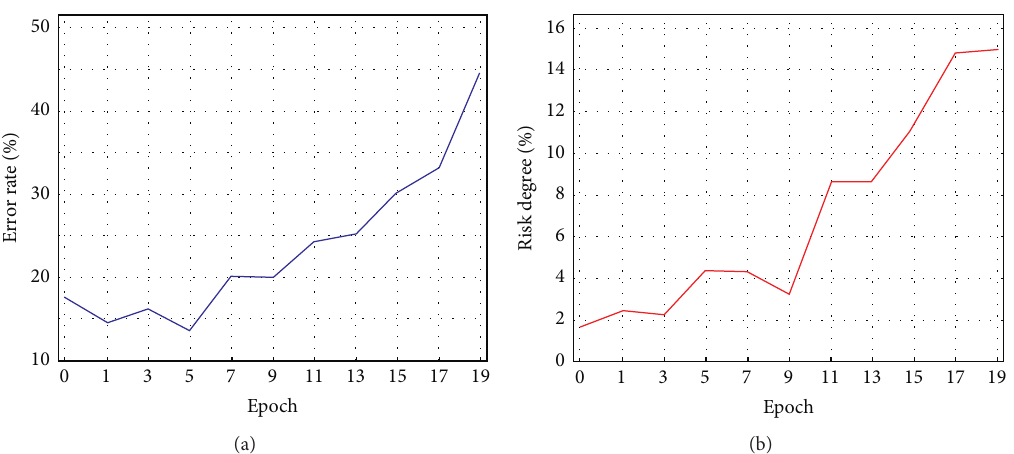
Figure 4: Risk assessment error rates (a) and risk degrees (b) for college student entrepreneurship based on big data analysis.